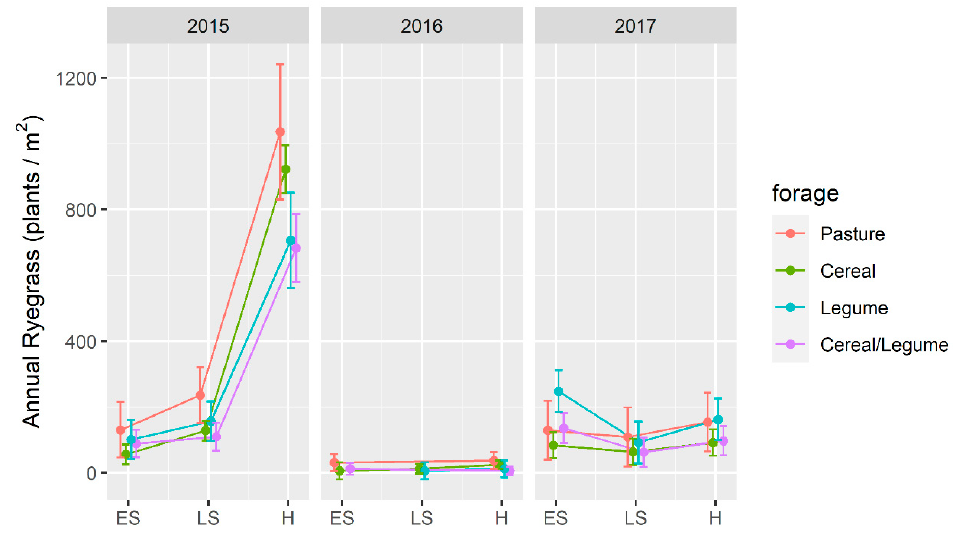
Figure 3. Annual ryegrass plant density (plants/m 2 ) in a wheat crop in the year following winter forage crops grown at Wagga Wagga, NSW compared to an unsown pasture. Forage crops were grown in 2015-2017, and harvested as early silage (ES), late silage (LS) or hay (H). Data displayed as the mean (•) ± 2 x standard error (length of line in each direction).